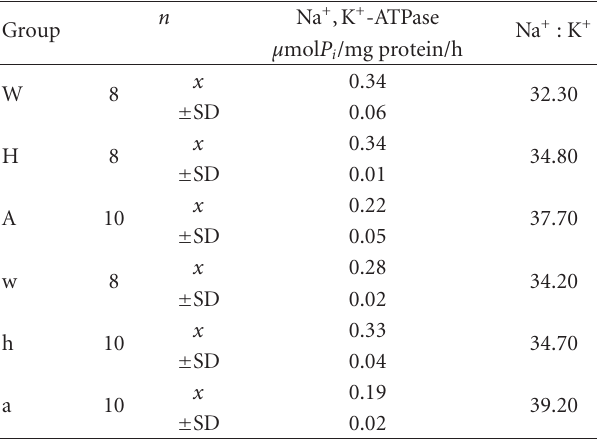
Table 4: The Na + , K + -ATPase activities of the erythrocytes and Na + : K + ions ratio in blood serum of stallions and mares Wielkopolska breed (W, w), Hanoverian breed (H, h), Ardenian breed (A, a).